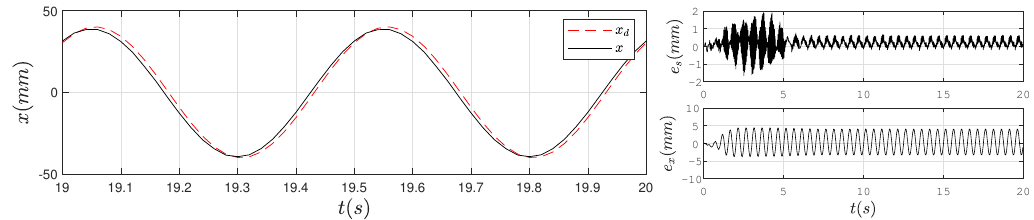
Figure 10. System output under the CCC controller and high-frequency excitation.